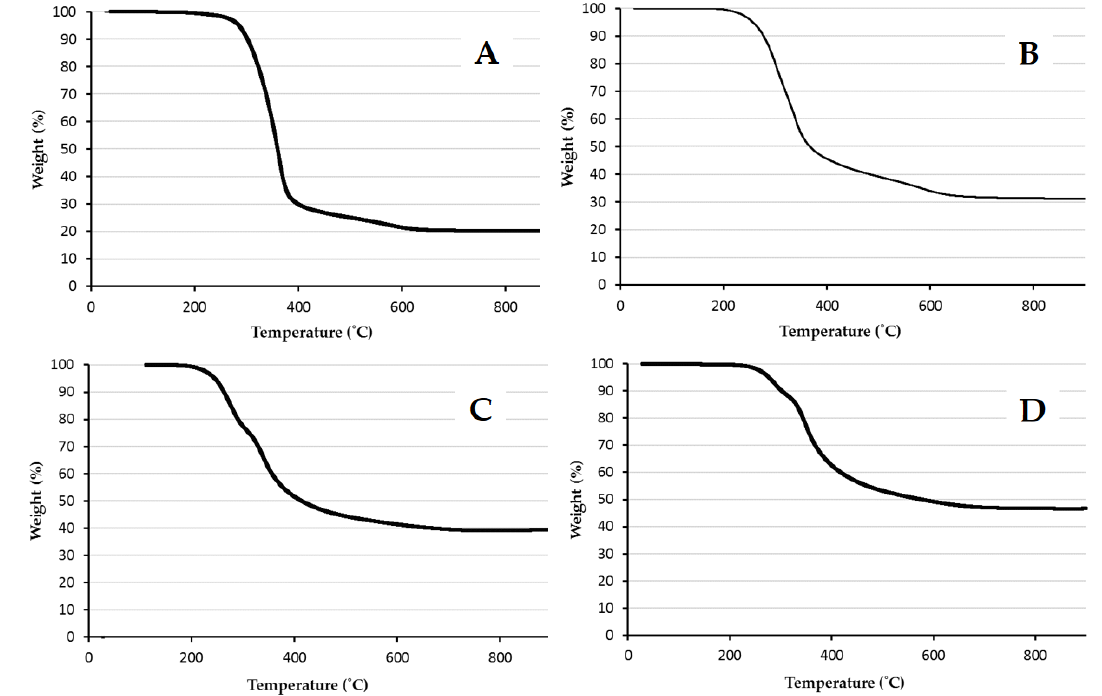
Figure 3. Thermogravimetric analysis (TGA) of particles obtained from a mixture MPTMS:styrene of ( A ) 20:80, ( B ) 50:50, ( C ) 80:20, and ( D ) 100:0.